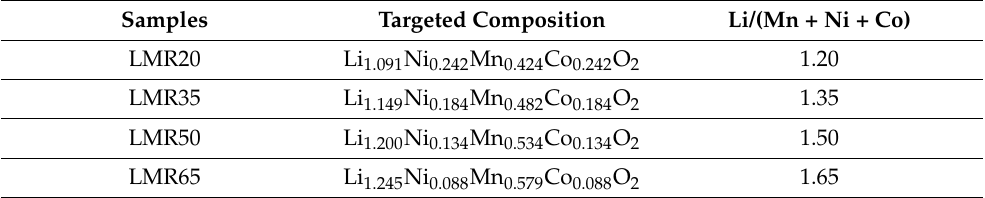
Table 1. Designations of the samples and their targeted compositions.